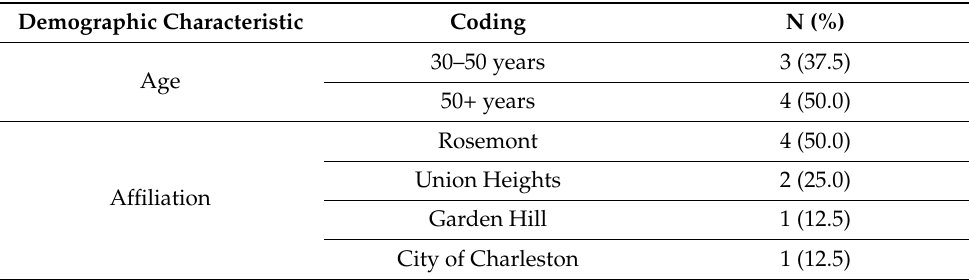
Table 2. Community participant affiliation and demographic